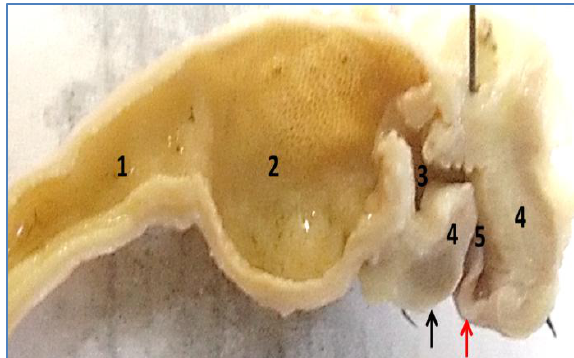
Figure, 1: Sagittal section of cloaca (turkey hen) shows: rectum (1), coprodeum (2), urodeum (3), cloacal sphincter muscles (4), proctodeum (5), and perforation of the left oviduct into the wall of urodeum (pin), dorsal labium of cloaca (Red arrow) and ventral labium of cloaca (Black arrow).